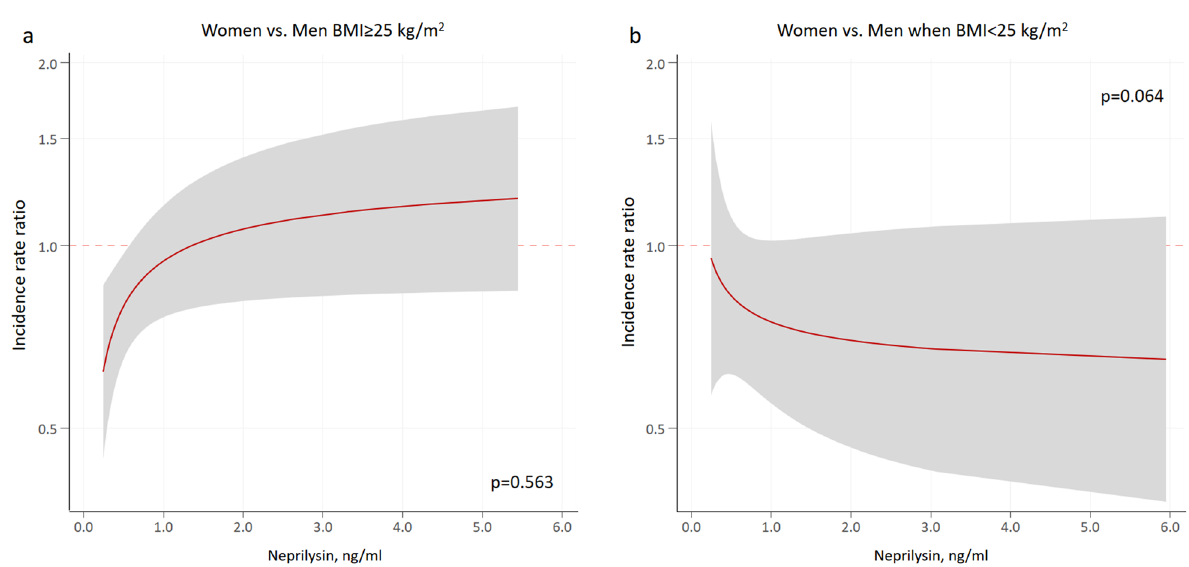
Figure 4. Soluble neprilysin and excess mortality risk in women versus men across body mass index values. BMI: body mass